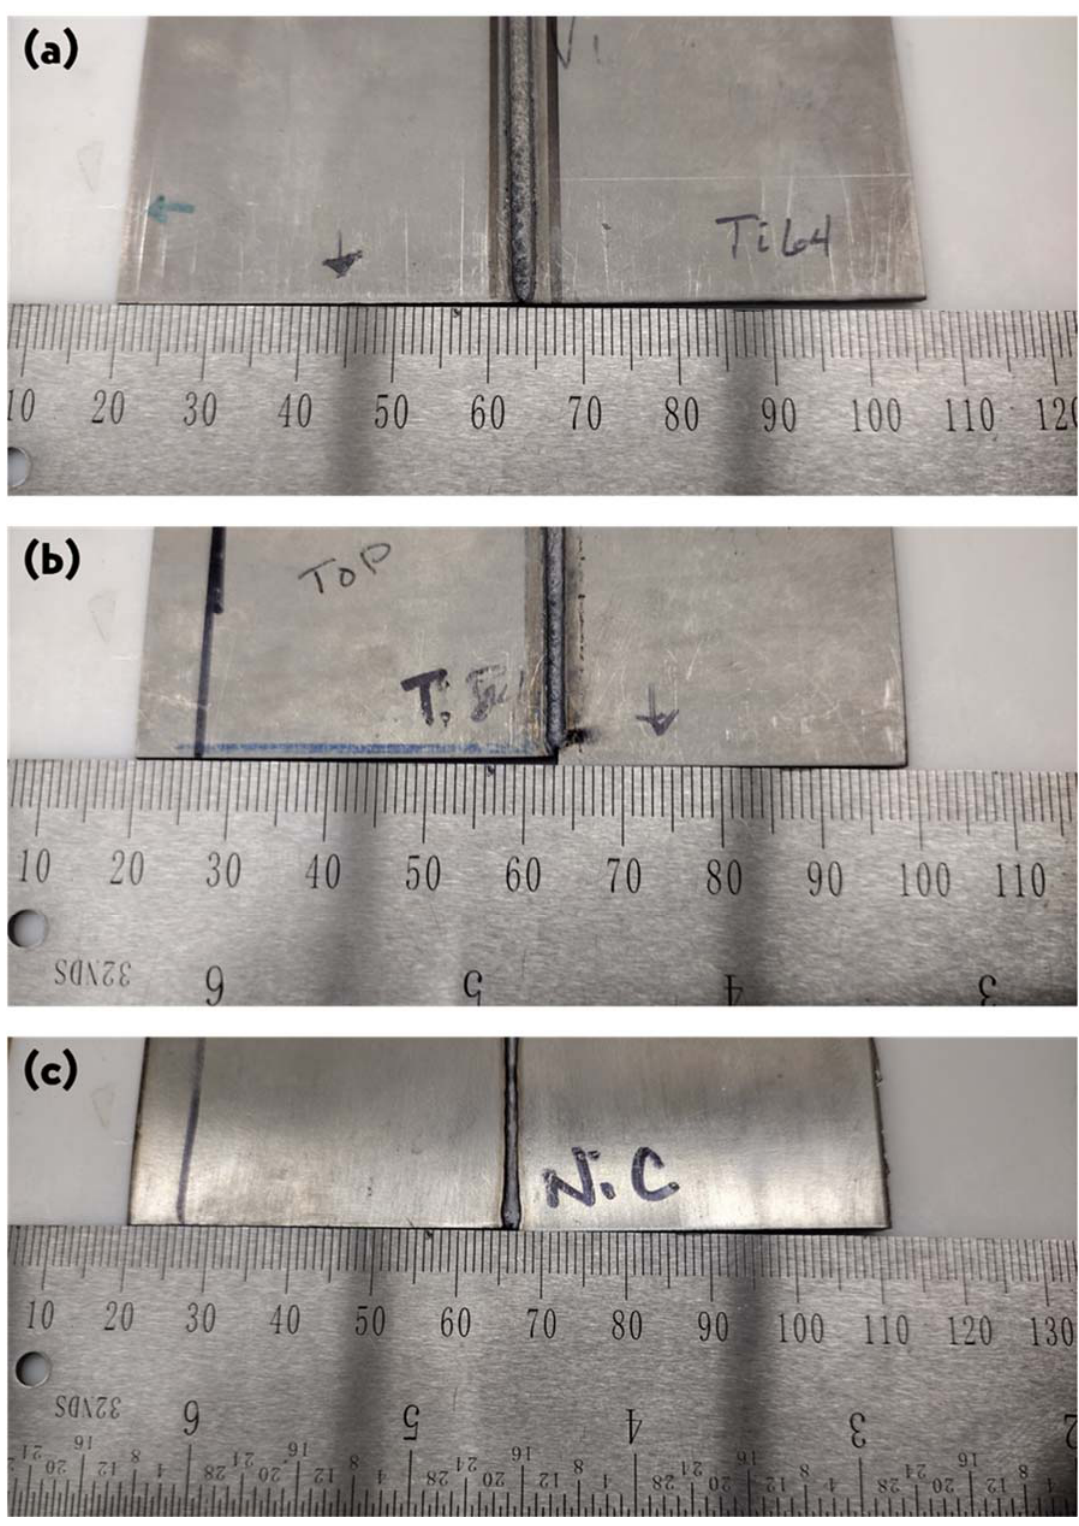
Figure 14. Photos displaying the top views of the deformation along the weld interface for trial 2 ′ s specimens; ( a ) at 5 mm/s, ( b ) at 20 mm/s, and ( c ) at 100 mm/s.